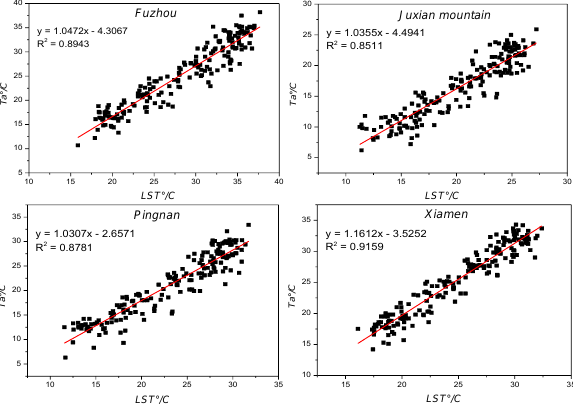
Figure 2. Ta and LST scatter diagram of eight stations.